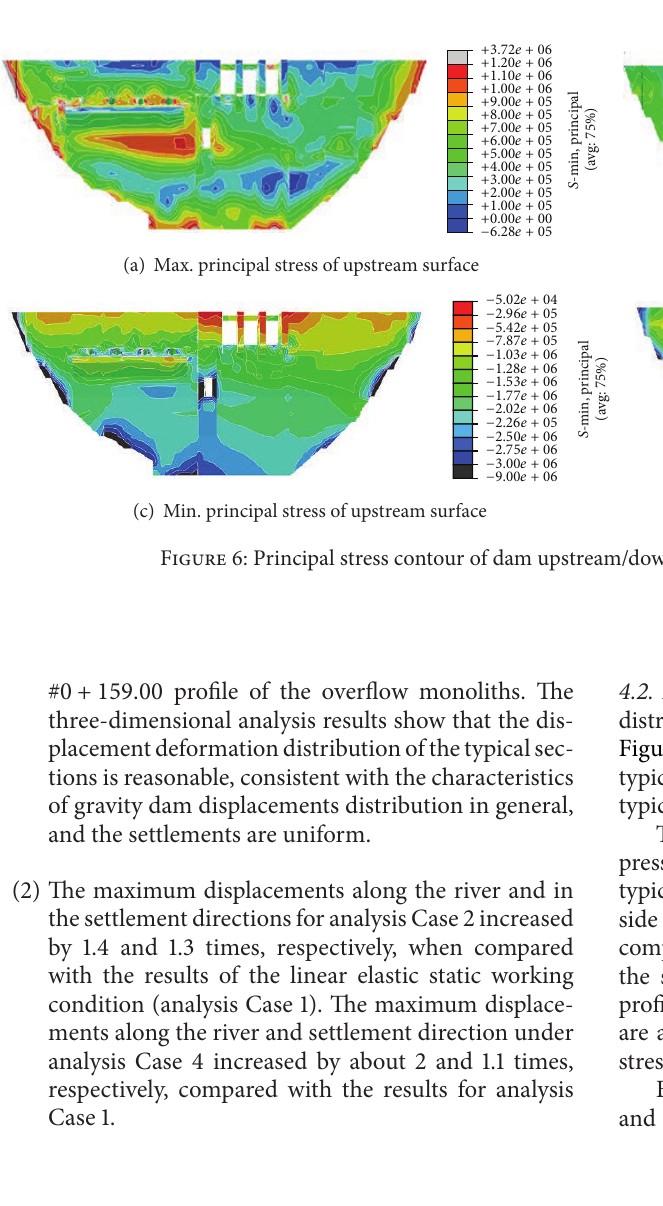
Figure 5: Dam displacement contour in various directions under analysis Case 4 (unit: m).